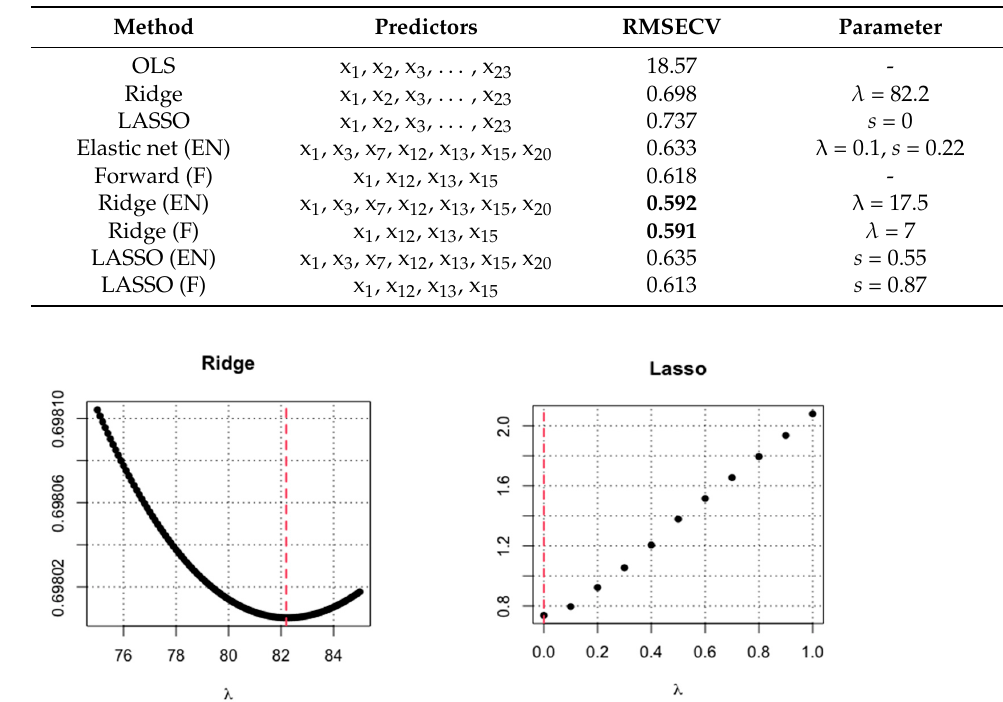
Table 3. Predictive errors for calculated models.